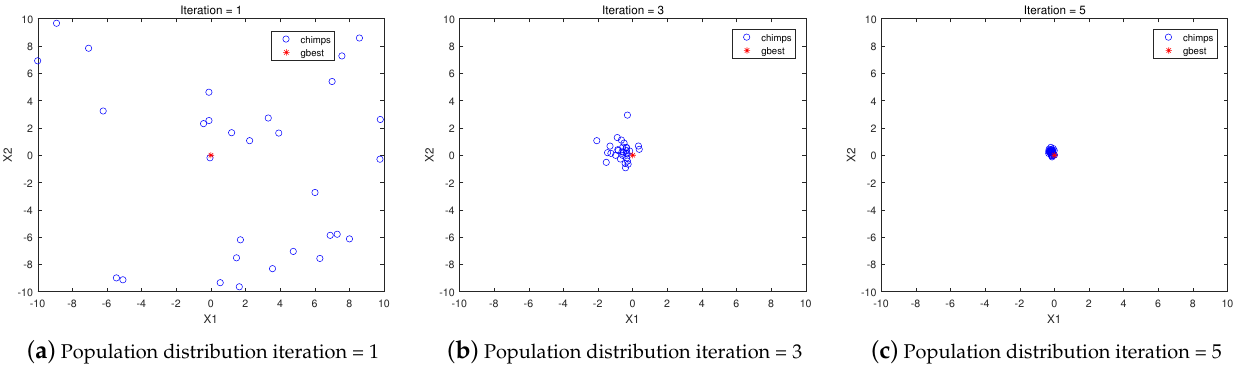
( b ) Population distribution iteration = 3 ( c ) Population distribution iteration = 5 Figure 2. Population distribution observed at various stages in